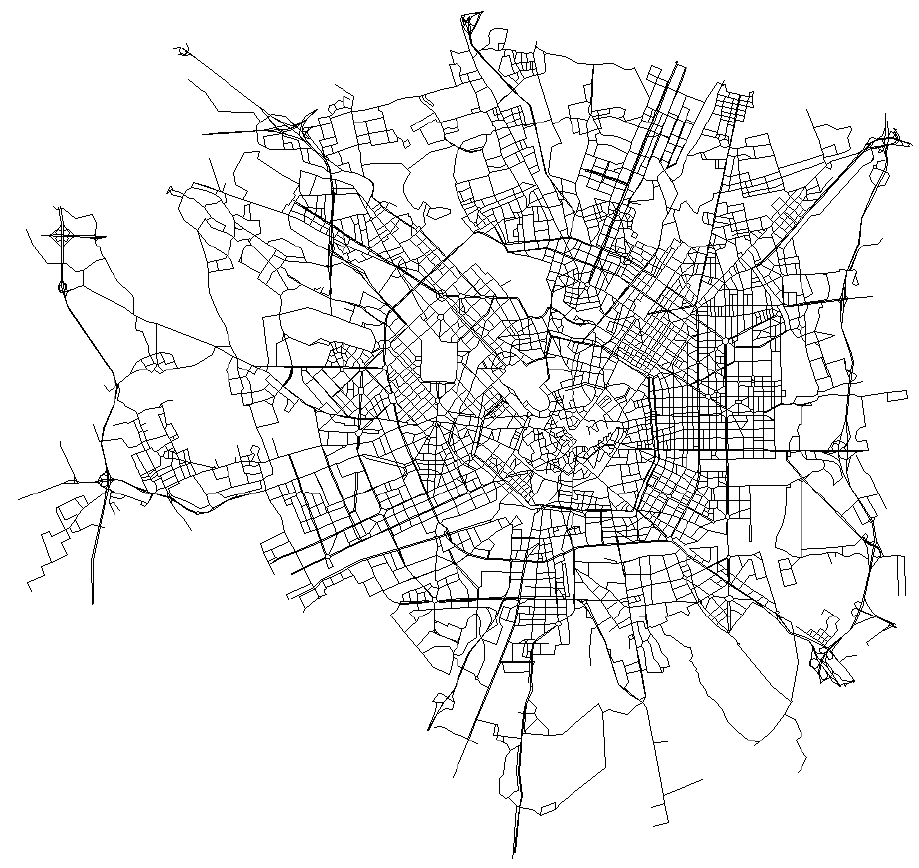
Figure 6. Road network of Milan during